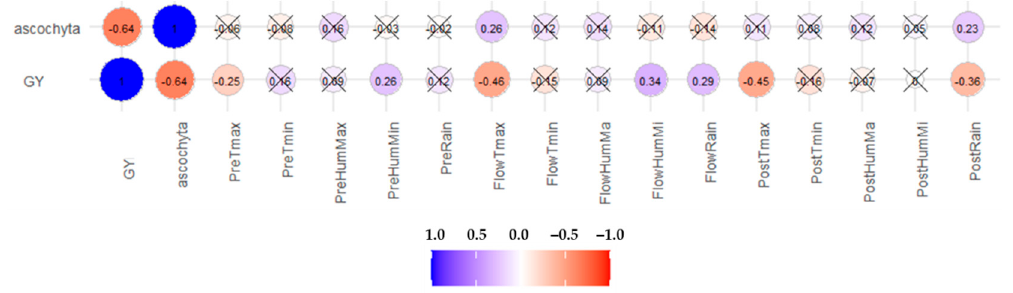
Figure 5. Graphical representation of the effects of climatic parameters and of disease incidence on grain yield and among them. Size of the dot indicates its effect on the trait, blue when positive, red when negative. The not statistically significant crossed.